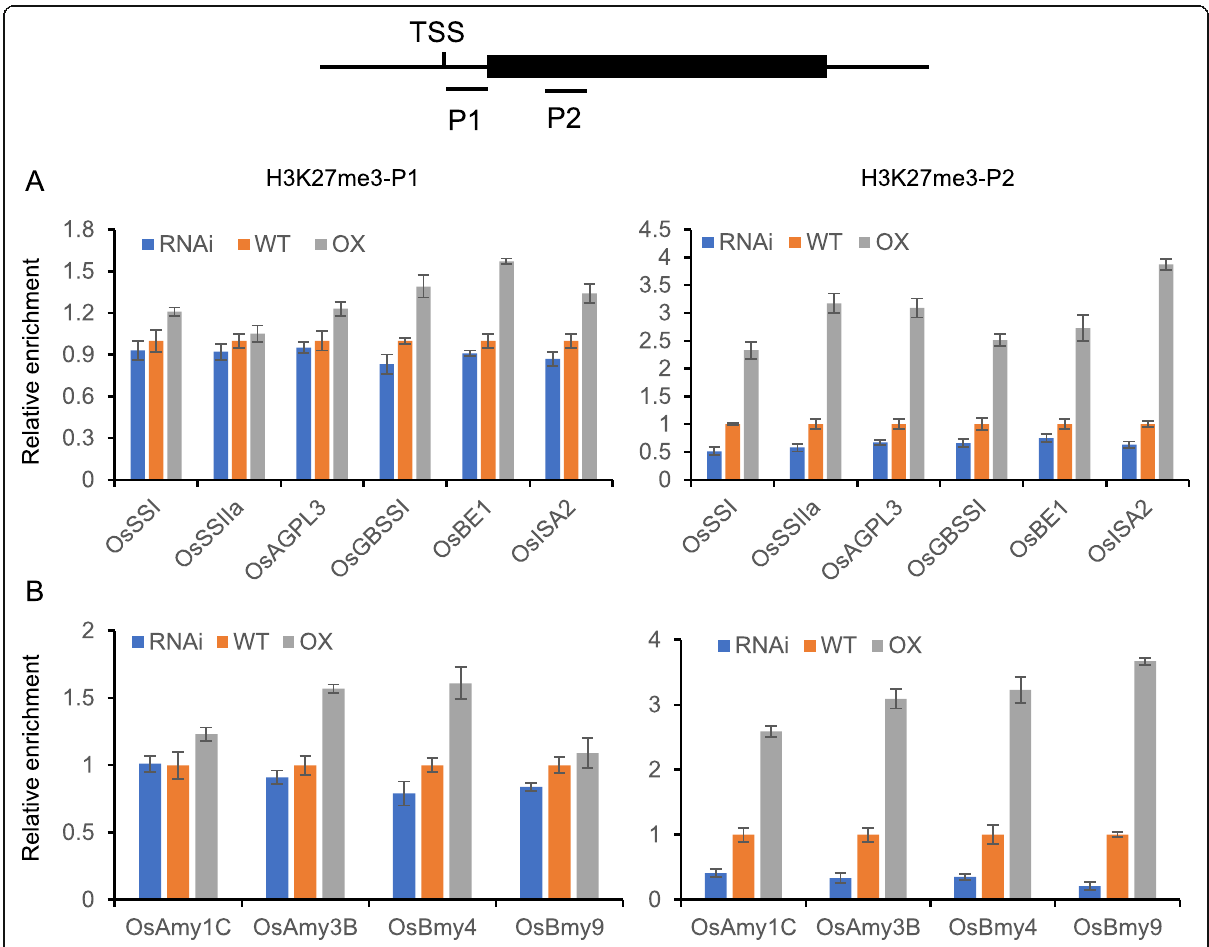
Fig. 4 SDG711 function in H3K27me3 of starch metabolism genes. Chromatin immunoprecipitation (ChIP) analysis of H3K27me3 of starch synthase genes ( a ) and amylase genes ( b ) in WT and SDG711 transgenic seeds at 3 DAP. H3K27me3 enrichment at the 5 ′ transcriptional start site (TSS) (P1) and 5 ′ end of the gene body (P2) was detected by quantitative PCR. Each q-PCR assay was repeated three times. Bars = mean ± SD from three technical